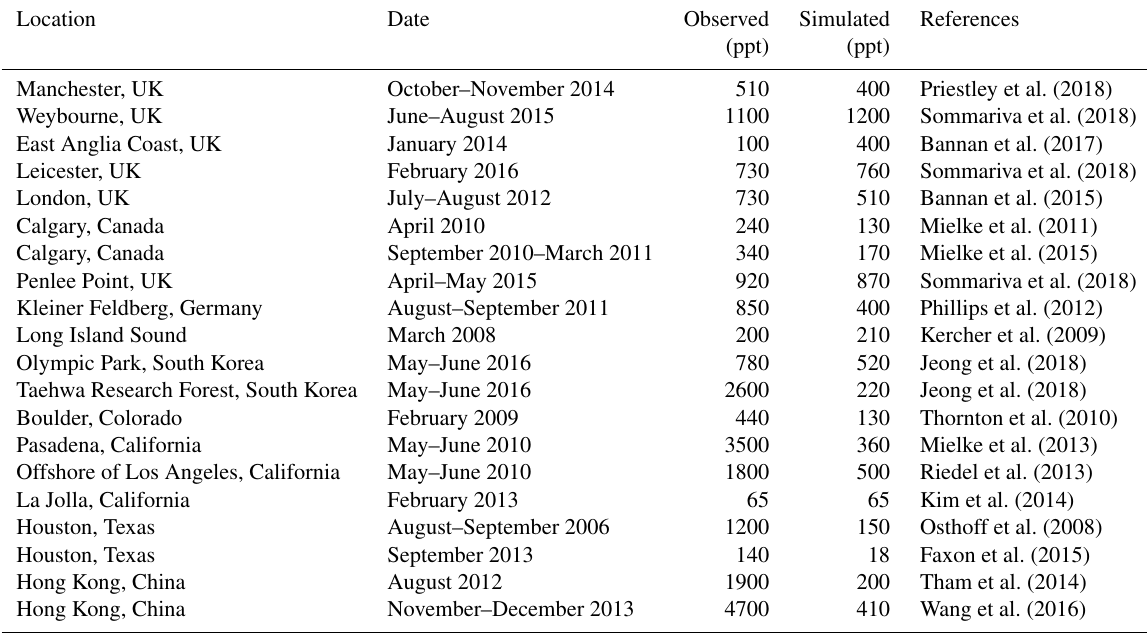
Table 5. Comparison of modeled maximum ClNO 2 mixing ratios to surface observations a .